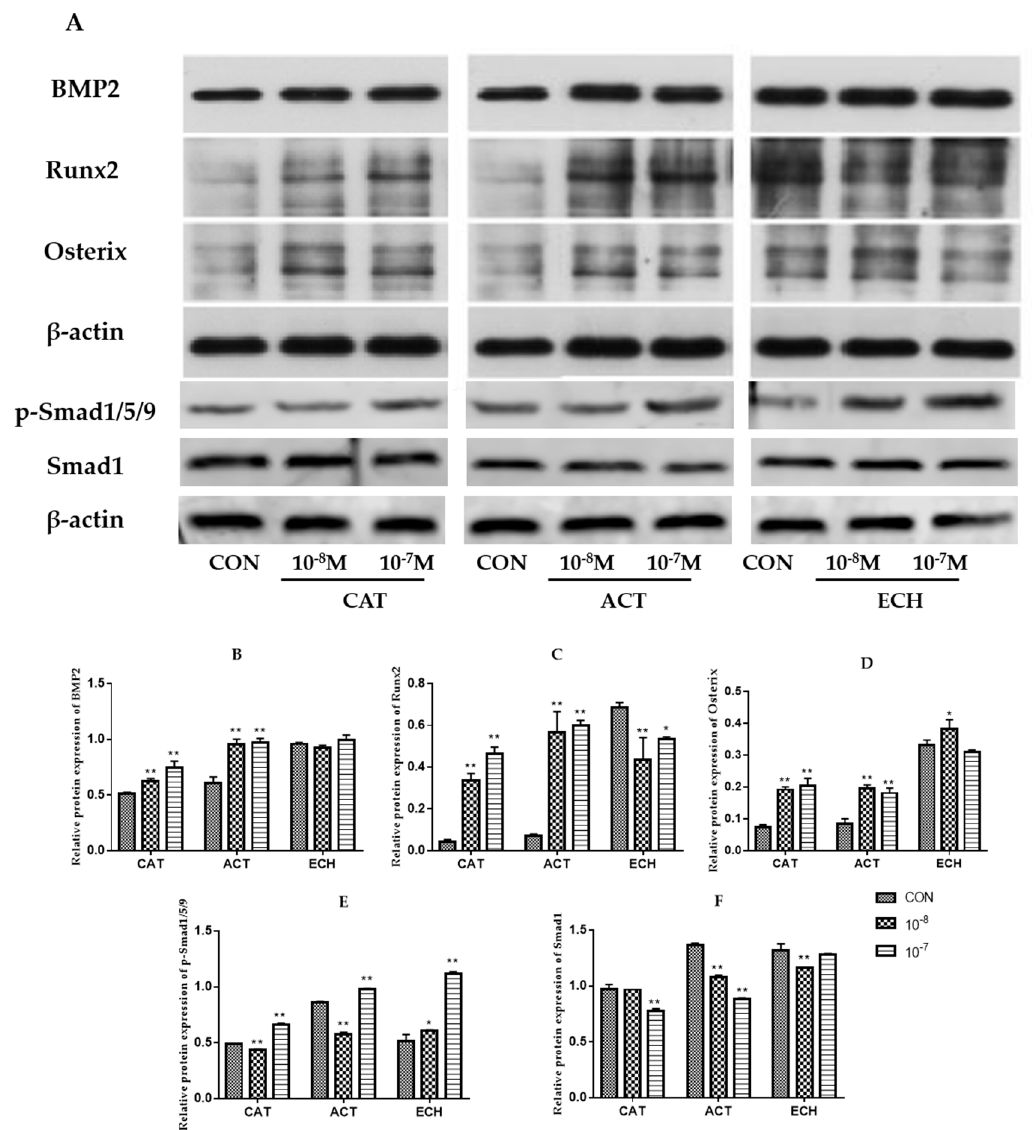
Figure 5. Effects of CAT, ACT, and ECH on the expression of BMP2, Runx2 , Osterix , p-Smad1/5/9 and Smad1 in osteoblastic MC3T3-E1 cells( A–F ). β -actin served as a protein loading control. The expression of key proteins in the BMP pathway was analyzed by Western-blot method. All data are expressed as the mean ± SD ( n = 3), * p < 0.05 and ** p < 0.01 as compared with the control